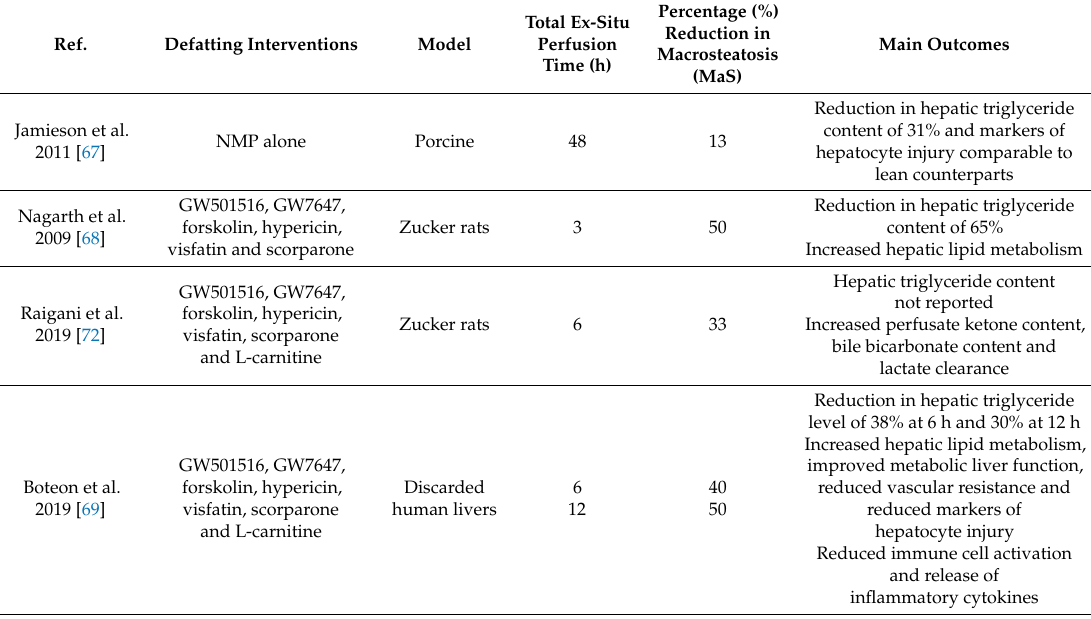
Table 5. Summary of defatting interventions and experimental